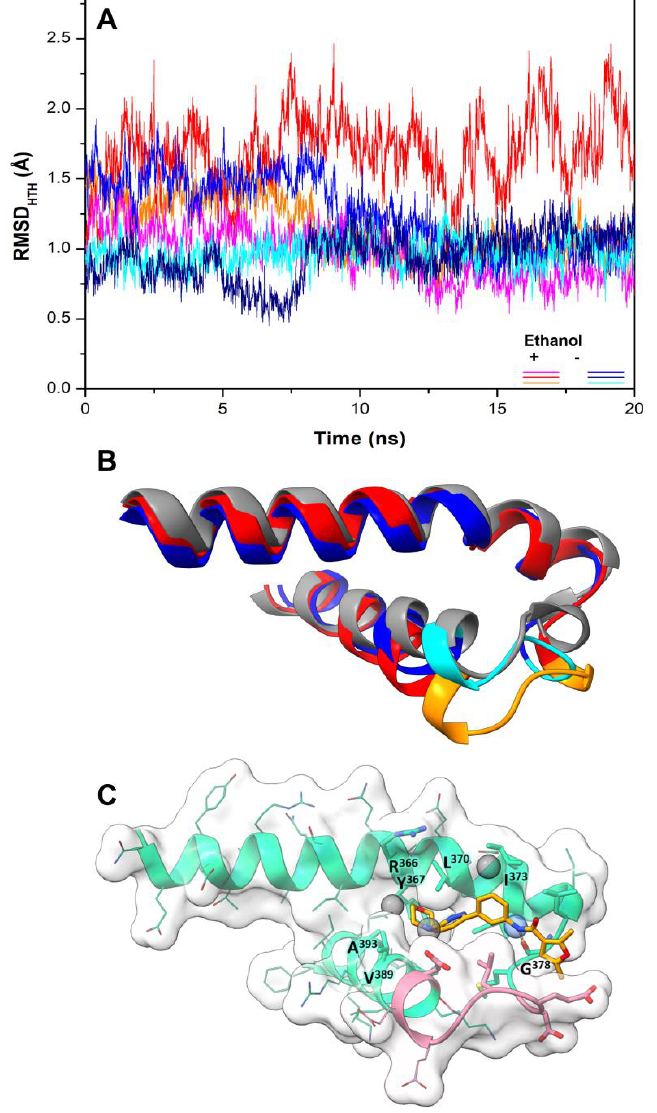
Figure 2. HTH dynamics and solvent sites determined from MD simulations. ( A ) RMSD was calculated using backbone atoms of the 1 HTH motif. Values from three MD simulations in pure water (blue colors) and three in water-ethanol mixture (red colors) are shown. ( B ) Average conformations of the HTH motif calculated over the last 10 ns of simulation. The open conformation obtained in one trajectory in a solvent mixture is shown in orange, while a closed conformation from one of the